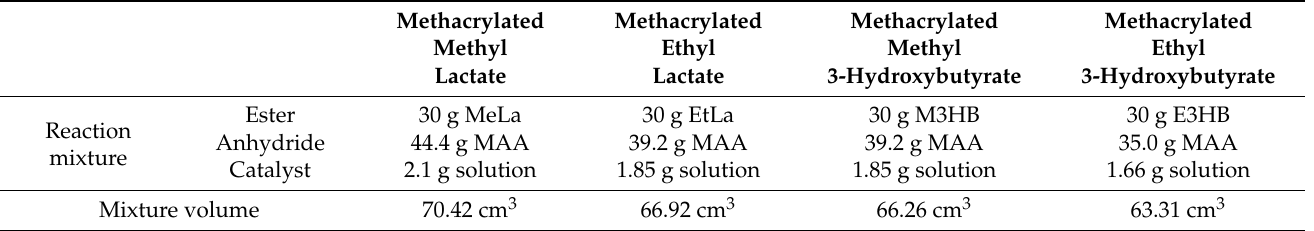
Table 3. Methacrylation mixture components for the synthesis of methacrylated alkyl